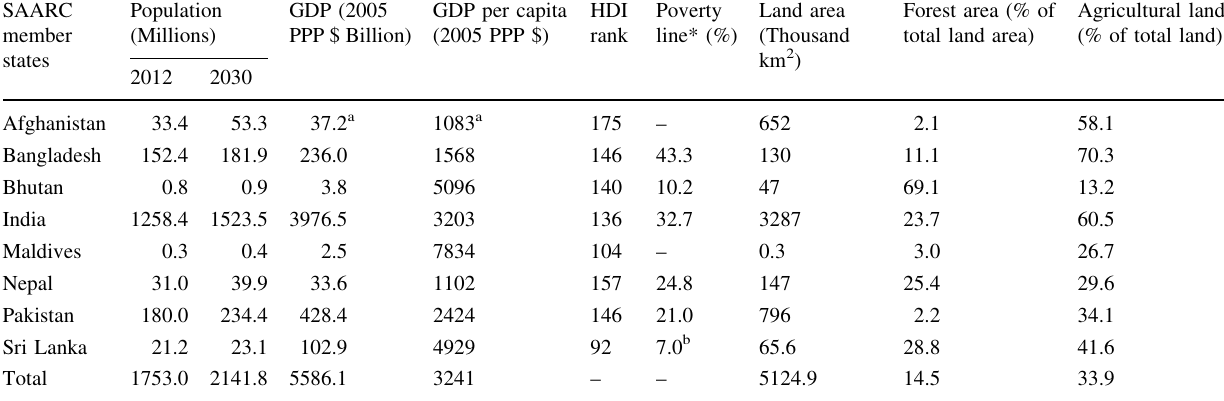
Table 1 Human development indicators of the South Asian Association for Regional Cooperation (SAARC) member states. Source : UNDP (2013), UNISDR/SDMC (2014) SAARC member